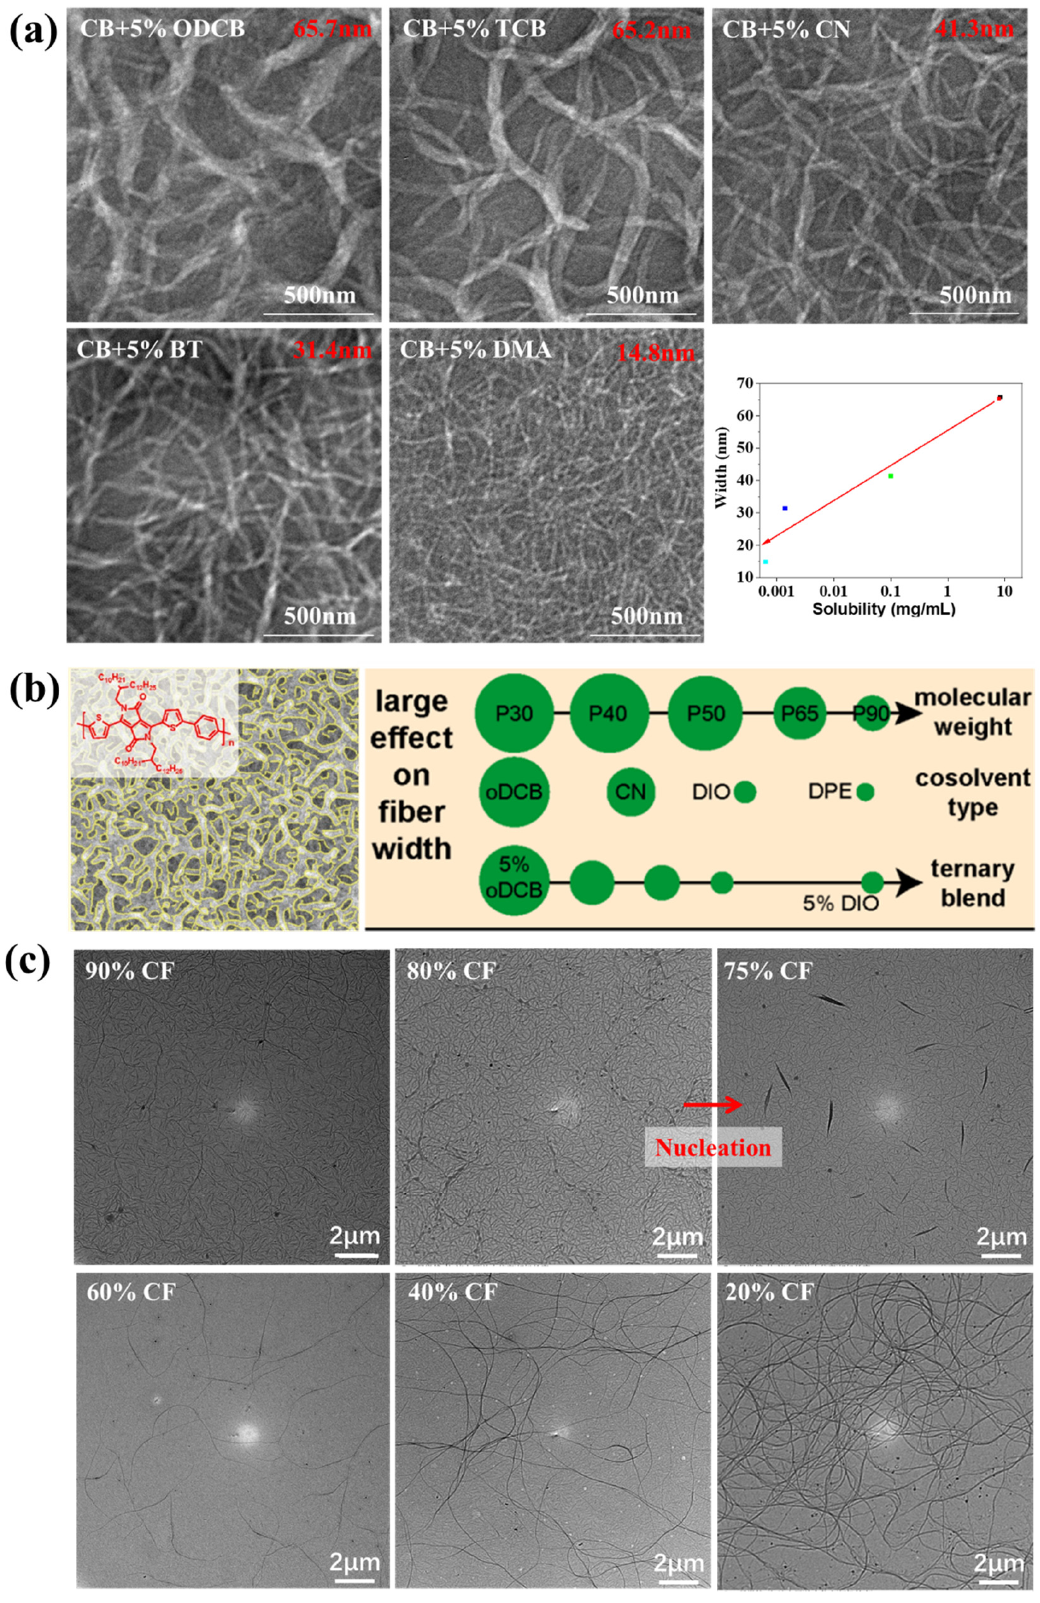
Figure 5. ( a ) Transmission electron microscopy (TEM) images of PDBT:PC 71 BM blend films processed with different solvent additives and the effect of the solubility of PDBT in solvent additives on